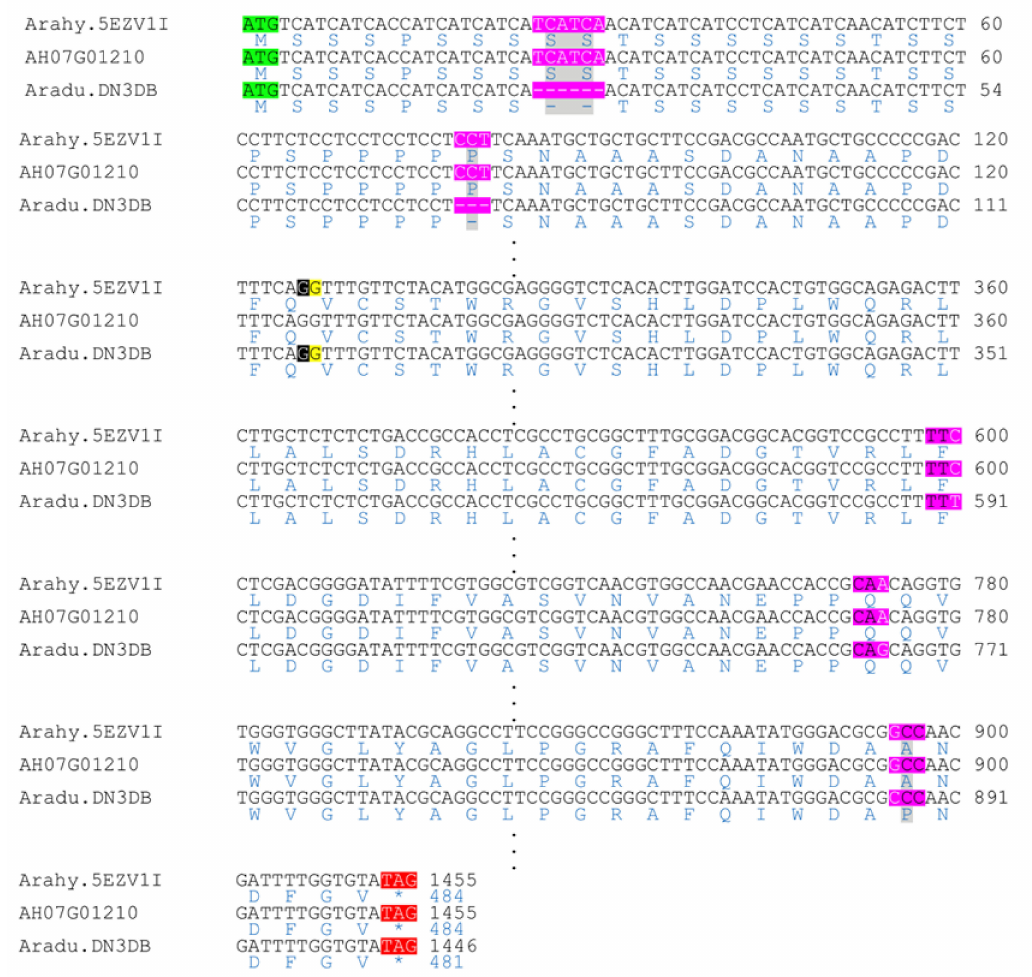
Figure 5. Sequence alignment of A. duranensis SAP ( Aradu.DN3DB ), A. hypogaea subs. hypogaea var. Tifrunner SAP ( Arahy.5EZV1I ) and A. hypogaea subs. fastigiata var Shitouqi SAP ( AH07G01210 ). The position of the intron is delimited by the two nucleotides highlighted in black and yellow on each gene. The CDS sequences are figured in black and the corresponding protein sequences in blue. Deletions and SNP variation are highlighted in pink in the CDSs. In the protein sequences, the deletions and the substituted amino acid are highlighted in grey. The start codon is figured in